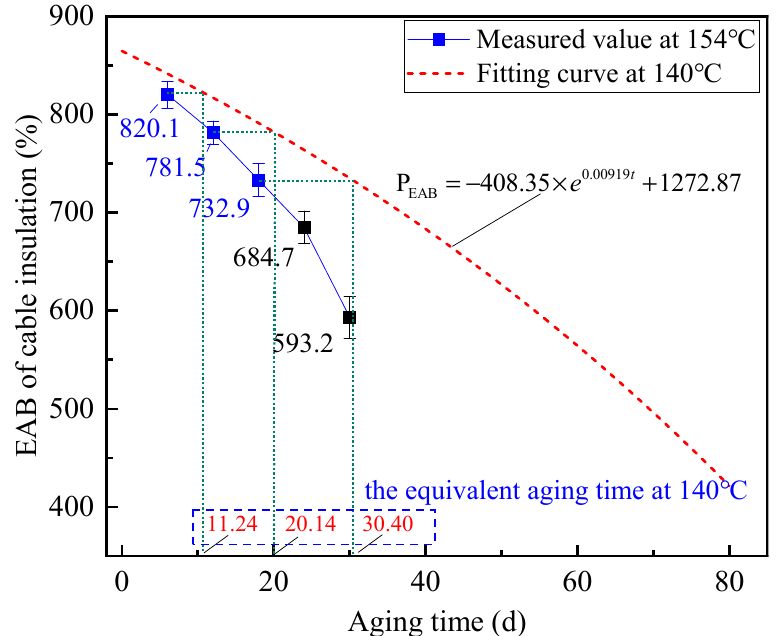
Figure 9. The EAB and the equivalent shift process of the aging cable insulation versus aging time at 154 ◦ C.